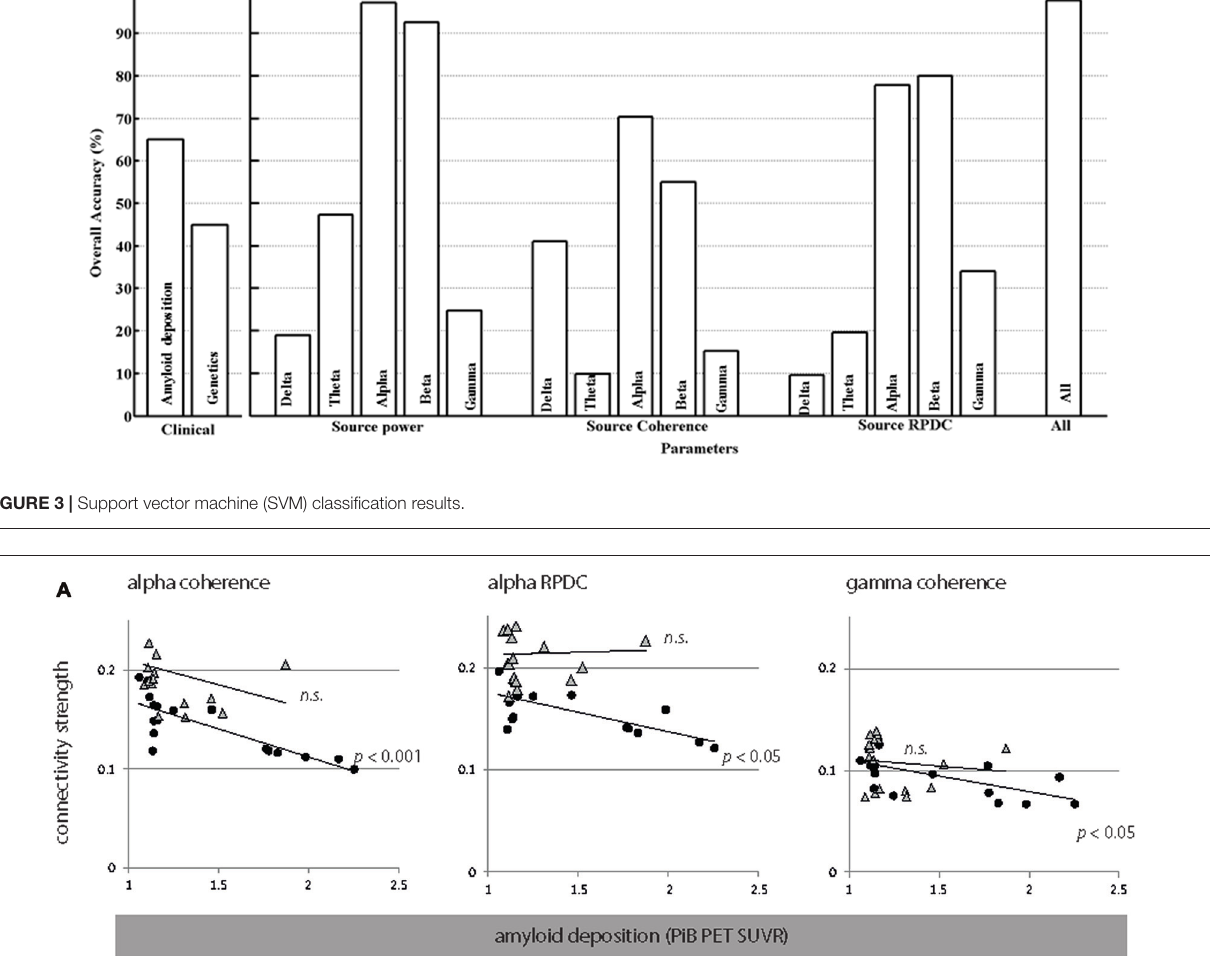
Frontiers in Aging Neuroscience |